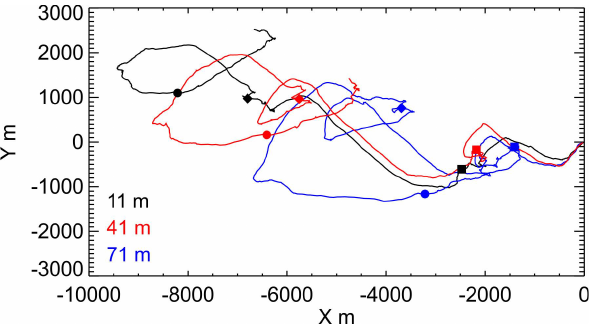
Fig. 5. Horizontal velocity data as a progressive vector diagram showing 11 (black), 41 (red) and 71 (blue) m depths. The start of each day is marked with a symbol (square = 322, diamond = 323 and circle = 324 NZST).